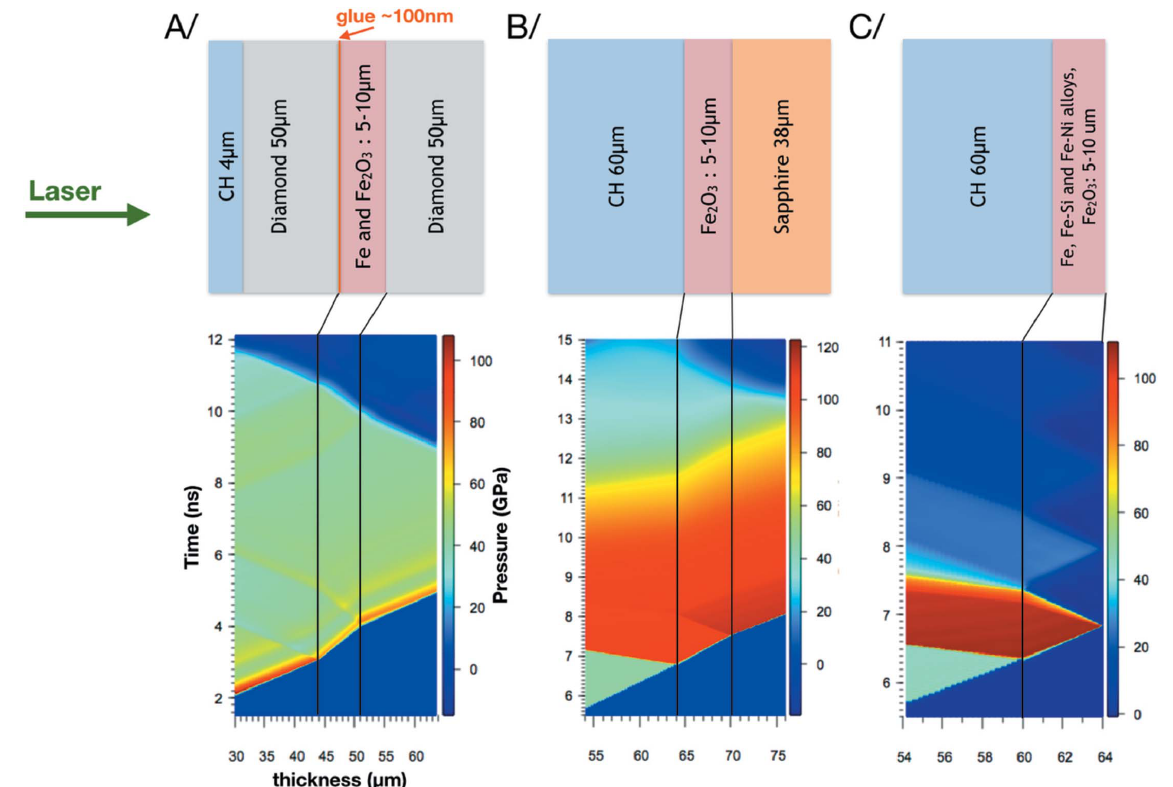
Figure 10 Fe, Fe alloys and Fe 2 O 3 target designs, and the corresponding hydrodynamics simulations for the case of Fe 2 O 3 .